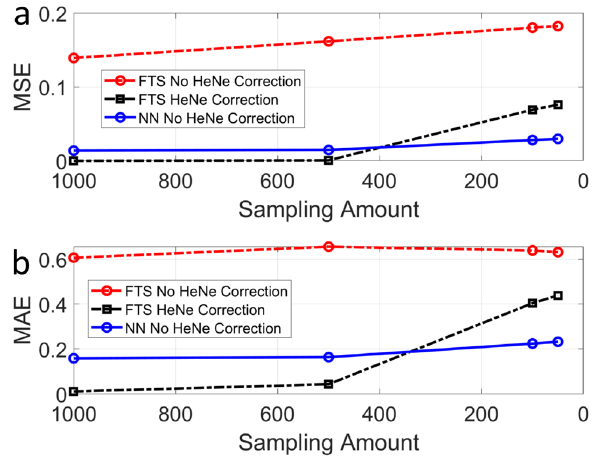
Figure 8. Comparison of traditional FTS with He-Ne correction, FTS without He-Ne correction, and NN without He-Ne correction for varying sampling amounts. MSE: mean squared error; and MAE: mean absolute error.